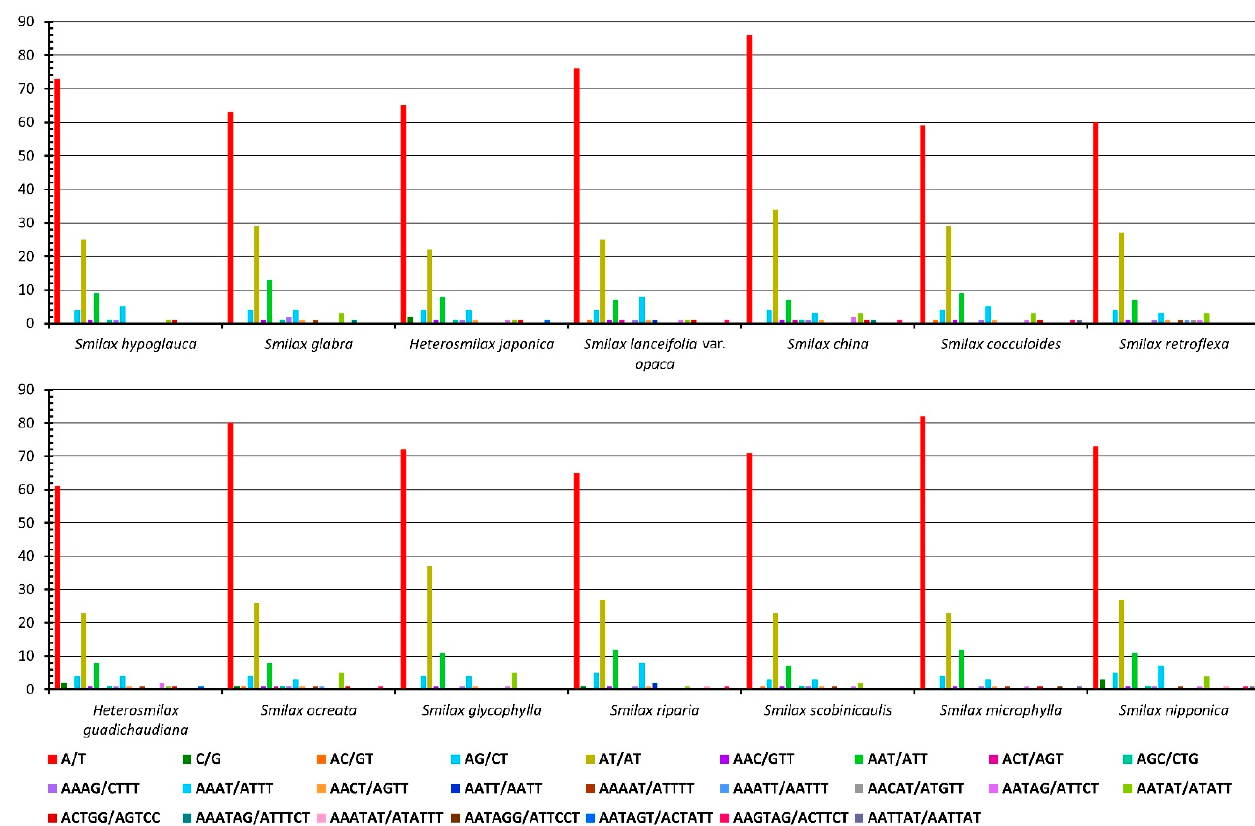
Figure 2. Complementarity of SSRs detected from fourteen Smilacaceae species.